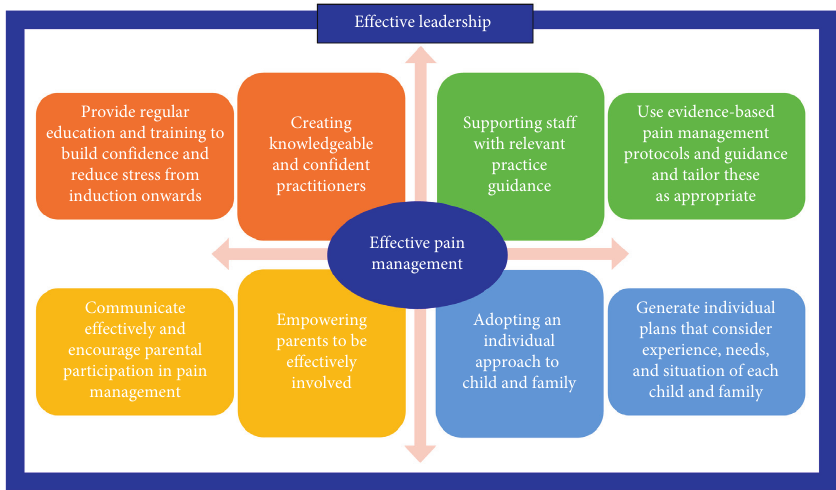
Figure 1: Framework for delivering effective pain